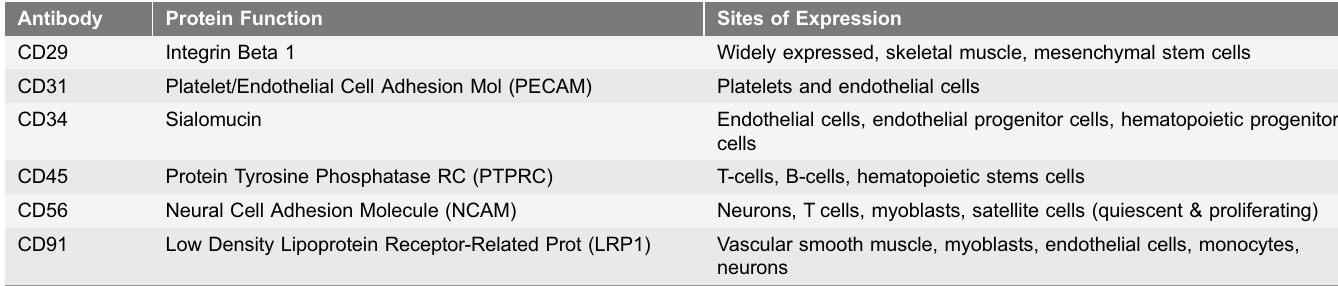
Table 1. Markers Used to Sort Subpopulations from Traumatized Human